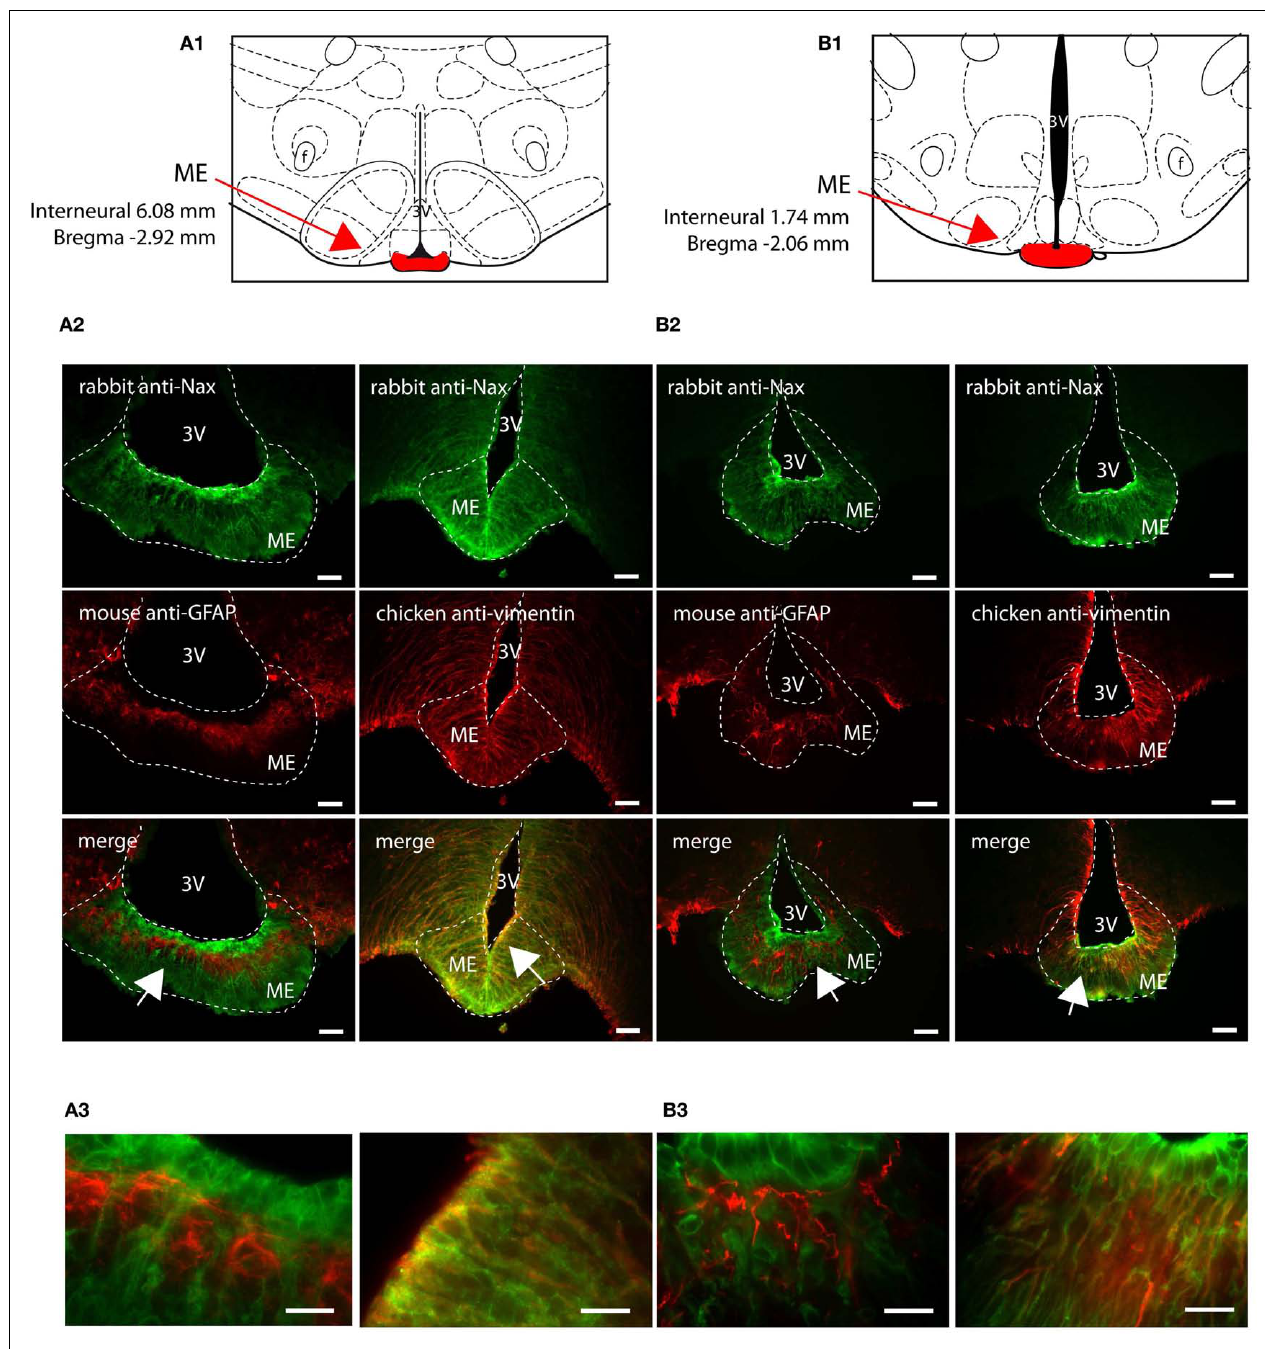
was identified using anti-GFAP and anti-vimentin fluorescent immunostaining (red). Scale bar: 100 µ m.The arrow head points the top-right, the bottom-right, and the bottom-left corner of the inset, which represents a high magnification zone of the ME in the rat (A3) and in the mouse (B3) ; scale bar: 20 µ m. Note that Na X staining is present in vimentin positive